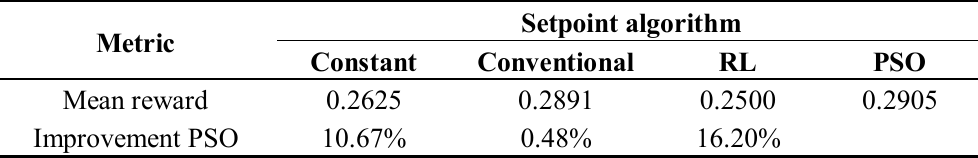
Table 1. Mean reward result obtained with each setpoint